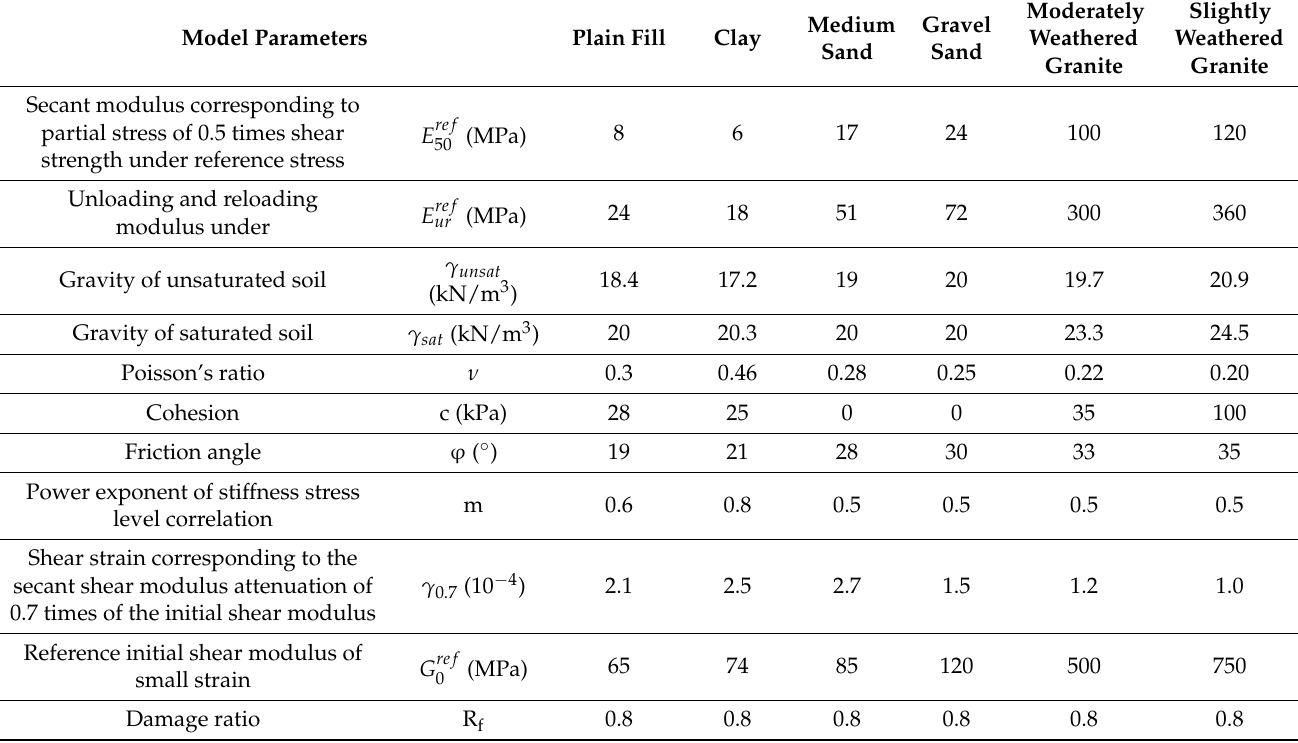
Table 2. Physical and mechanical parameters of the soil layer.